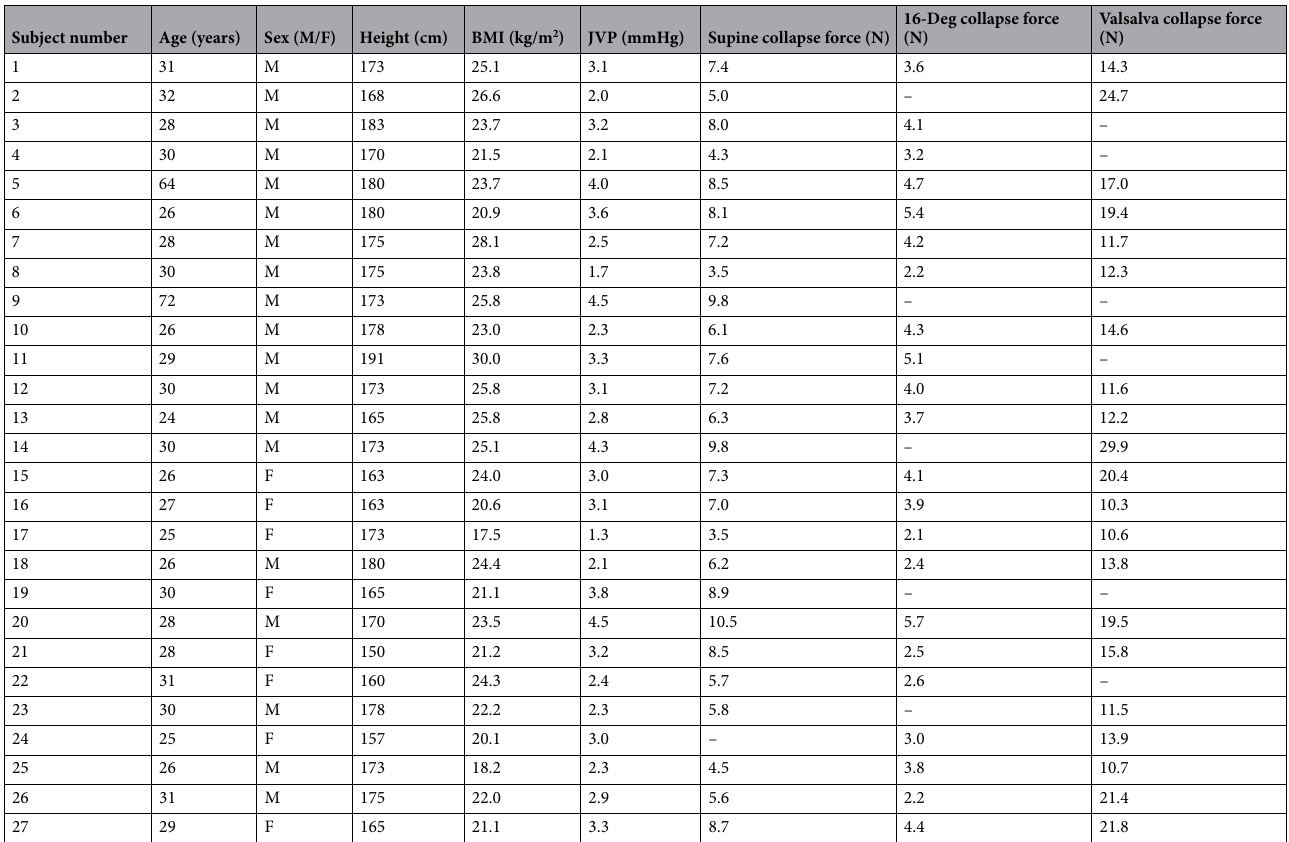
Table 1. Subject data population and results. The sixth column is the noninvasive jugular venous pulsation height measurement while the last three columns are the experimental collapse force measurements. Dashes in the last three columns indicate no collapse force is obtained for the given condition and